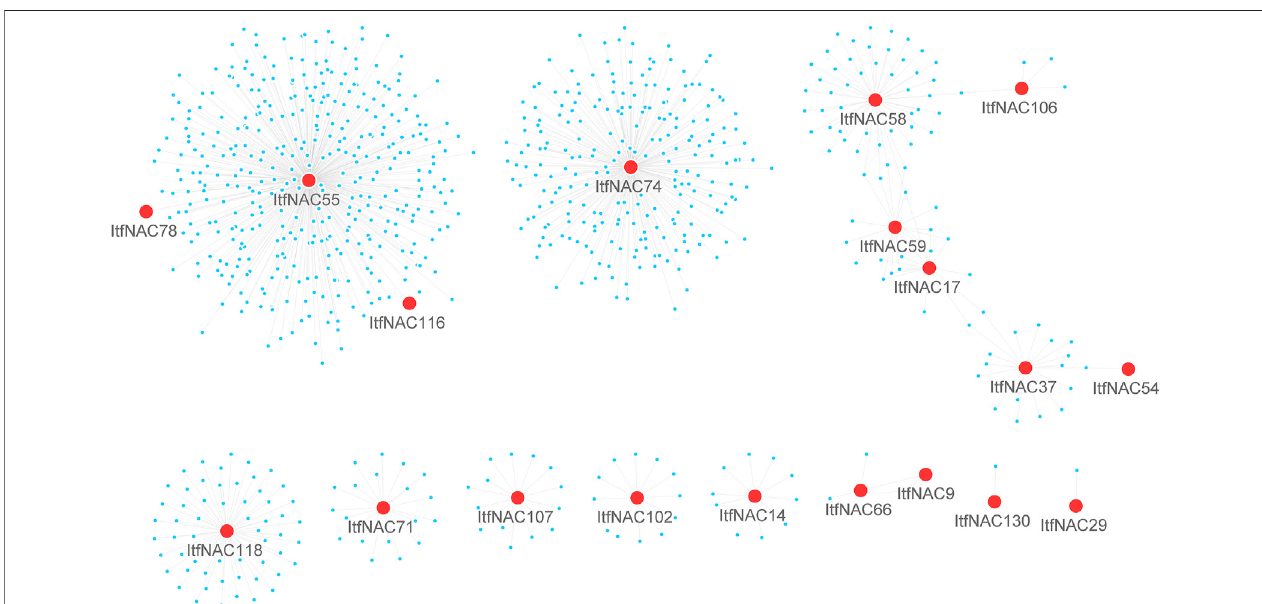
FIGURE 6 | Interaction networks of ItfNAC genes. The red circle indicates NAC family proteins, and blue circle indicates other proteins.